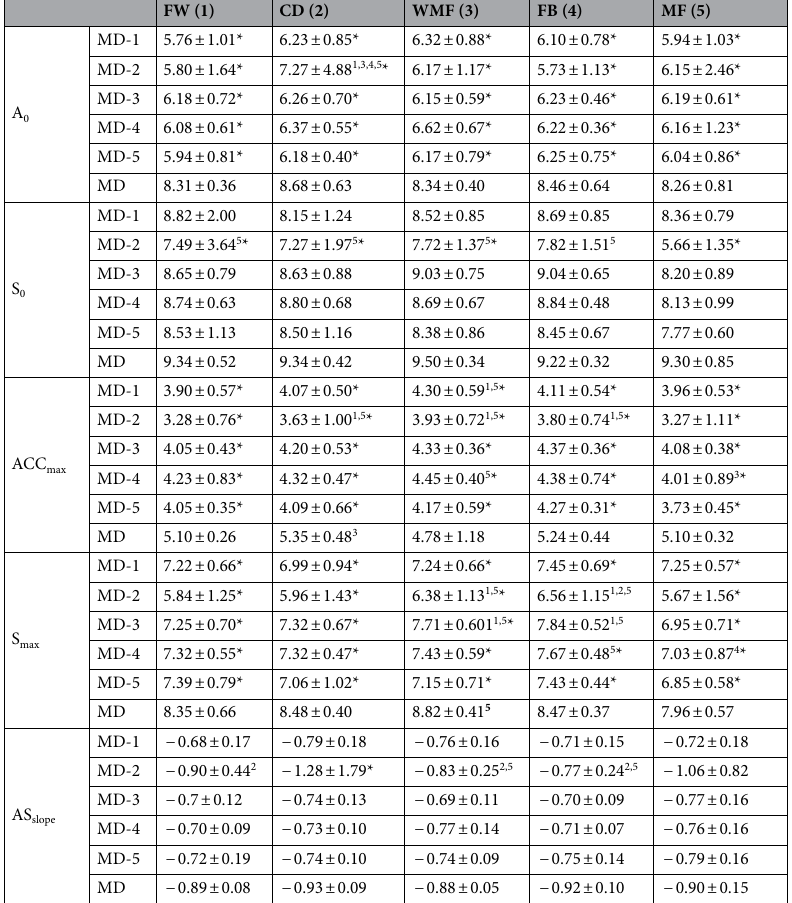
Table 2. Acceleration-Speed profile variables values by playing position and microcycle day. Variables: A 0 theoretical maximal acceleration, S 0 theoretical maximal speed, AS slope − A 0 /S 0 , ACC max maximal acceleration with an initial speed above 3 m/s and S max maximal speed. MD matchday. FW forward, CD central defender, WMF wide-midfielder, FB full-back and MF midfielder. *Differences with MD ( p < 0.05). 1 Differences with FW ( p < 0.05). 2 Differences with CD (< 0.05) 3 Differences with WMF ( p < 0.05). 4 Differences with FB ( p < 0.05). 5 Differences with MF ( p <